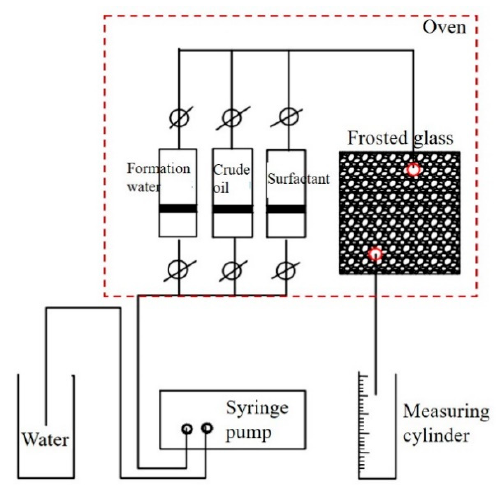
Figure 3. Schematic diagram of the visual oil displacement experiment device.